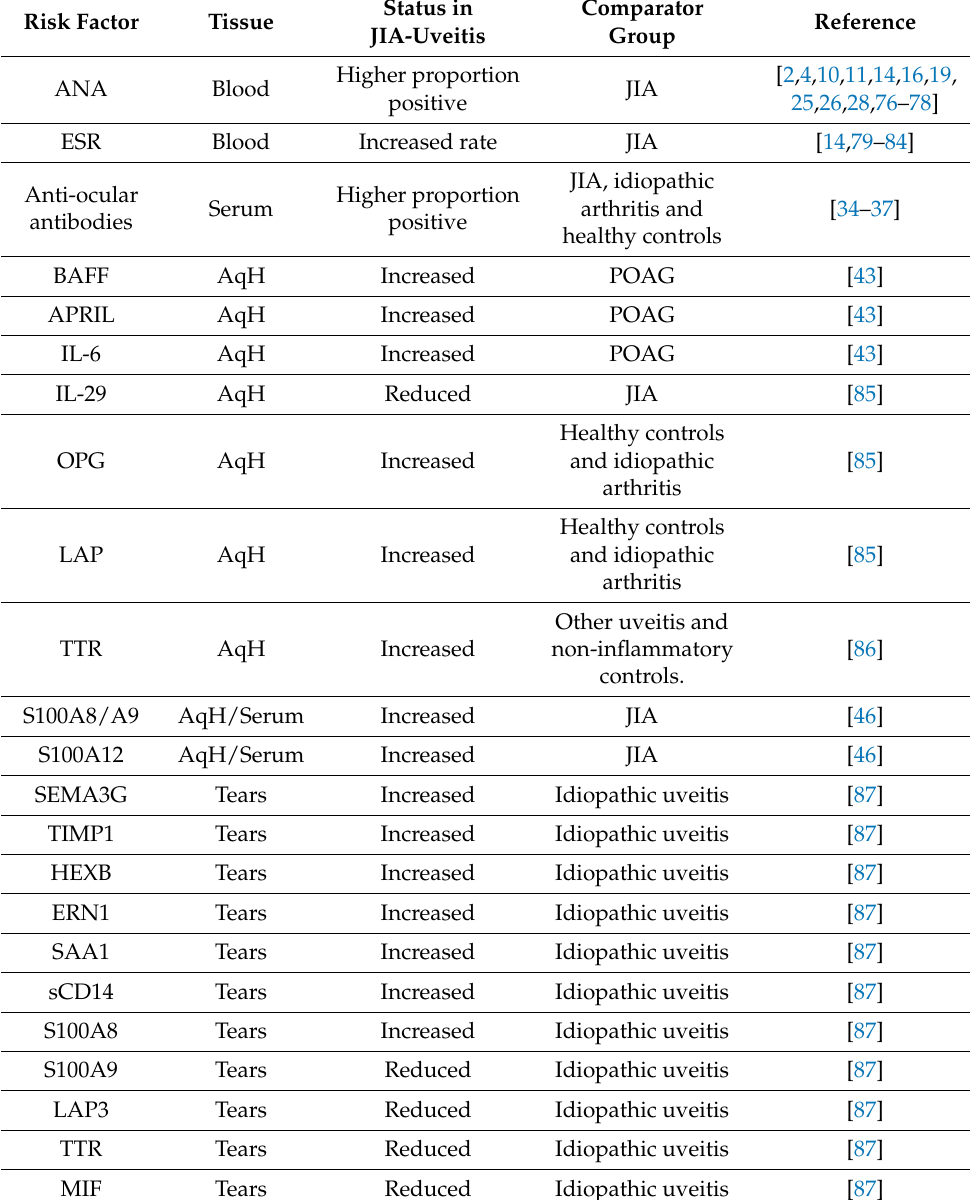
Table 2. Potential biomarkers in JIA-associated